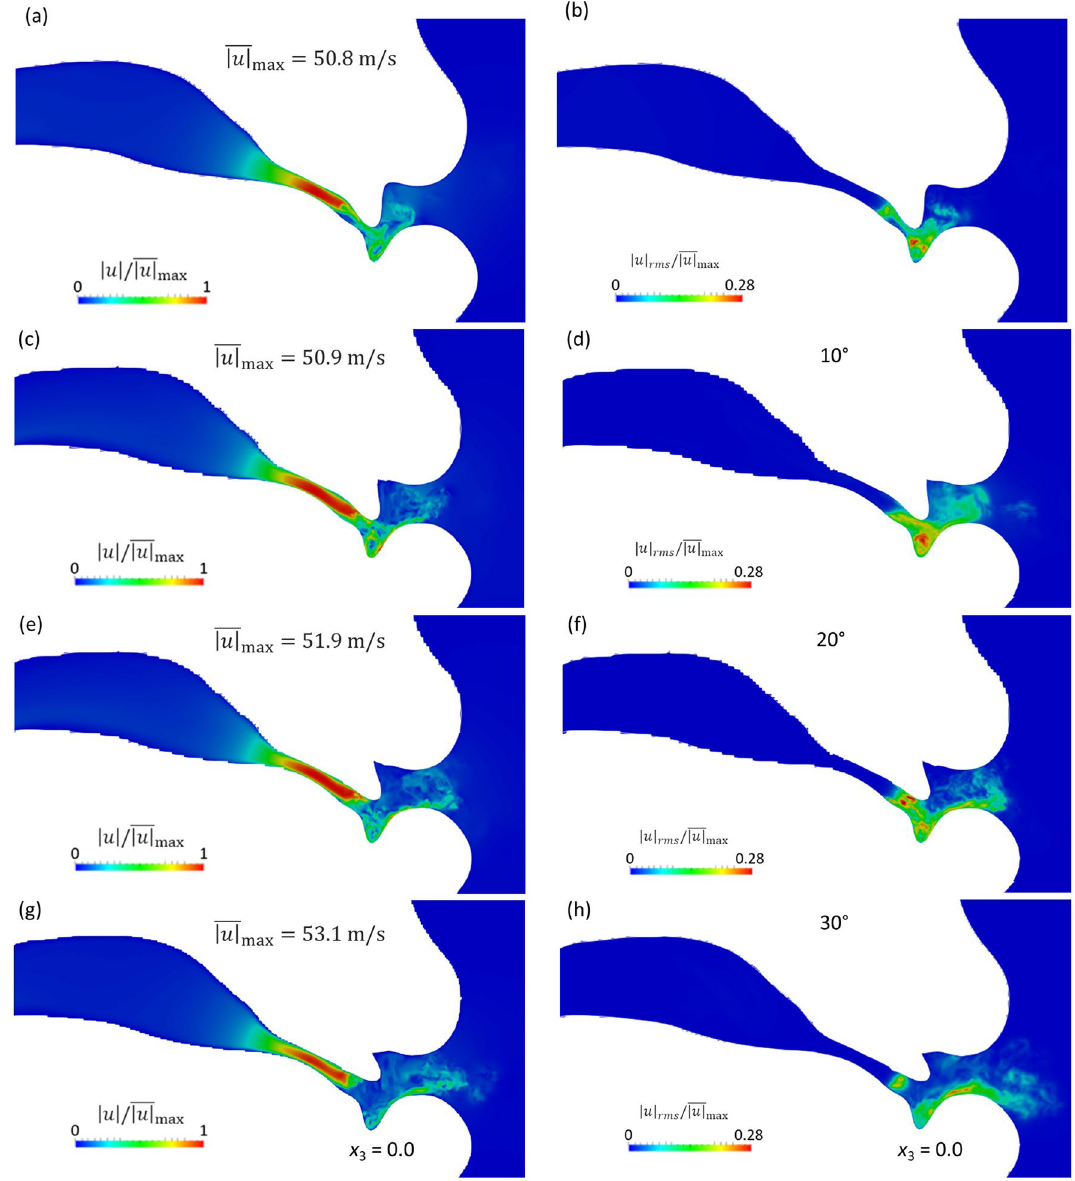
Figure 5. ( a,c,e,g ) Normalized instantaneous velocity magnitude and ( b,d,f,h ) root mean square (RMS) of the velocity fluctuations at t = 0.015 s for the ( a,b ) 0°, ( c,d ) 10°, ( e,f ) 20°, and ( g,h ) 30°